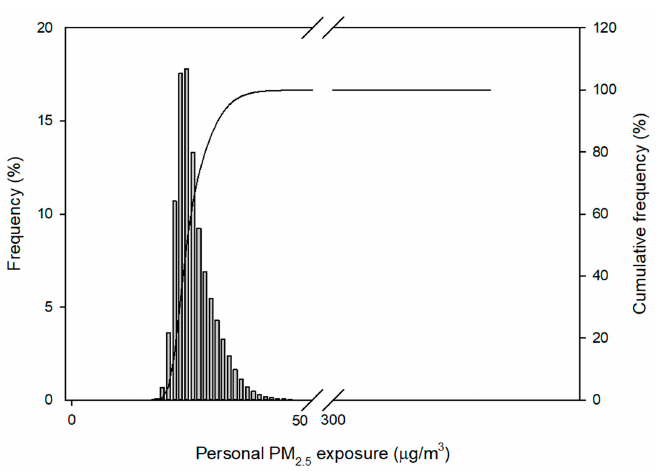
Figure 4. Personal exposure levels to PM 2.5 ( μ g/m 3 ).